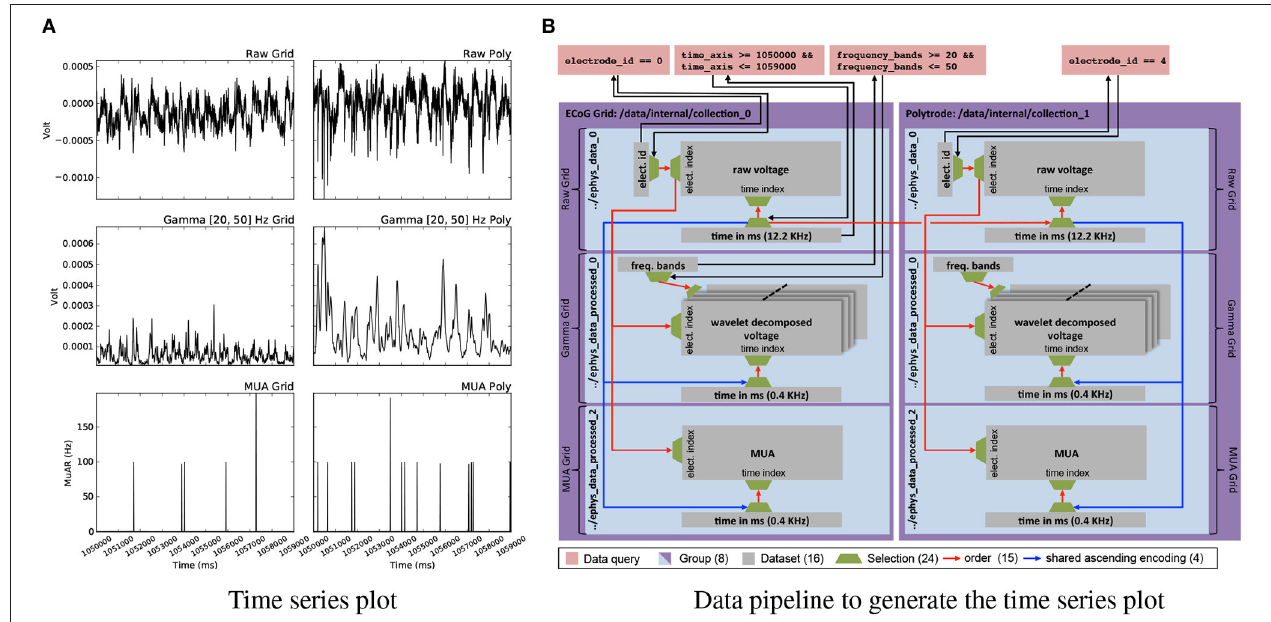
FIGURE 7 | (A) Plot of electrode 0 of the ECoG grid data (left) and electrode 4 of the polytrode data for time = (1050000,1059000) ms for the raw voltage recorded at 12.2 KHz (top) and the processed gamma (middle) and multi-unit activity (MUA) (bottom) data. (B) Graph illustrating the construction of the plot shown in (A) . While the plot may appear simple, the task of simultaneously visualizing data from different modalities and processing stages requires a complex network of datasets, selections, and relationships for mapping selections to enable the reliable and consistent extraction of matching data across datasets.